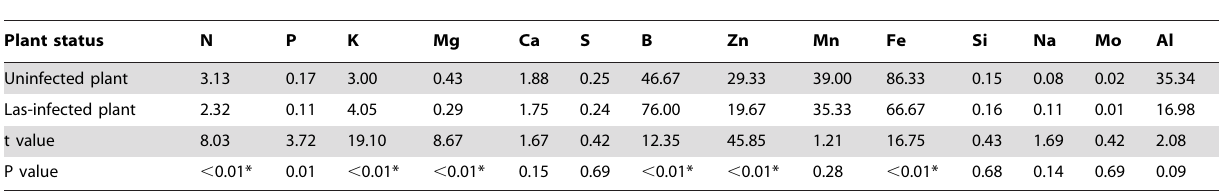
Table 2. Differing levels of various nutrients between Las-infected and non-infected Citrus sinensis plants.